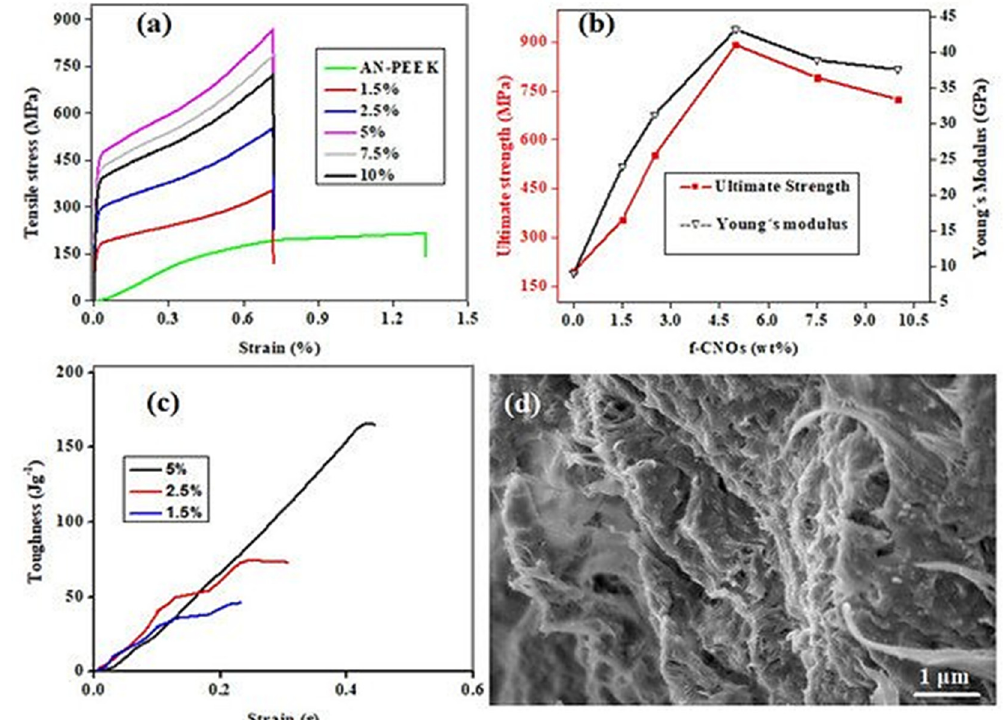
Figure 5. Physicomechanical analysis of biopolymer composite films employing quantitative techniques: ( a ) load displacement; ( b ) ultimate strength elastic moduli; and ( c ) impact–strength–strain graphs from uni-axial tensile nanocomposite thin films. ( d ) SEM micrographs of the fractography of biopolymeric nanocomposites comprising 5% of f-CNOs, produced by tear testing on perforated grooved specimens. Reproduced with permission from [35].